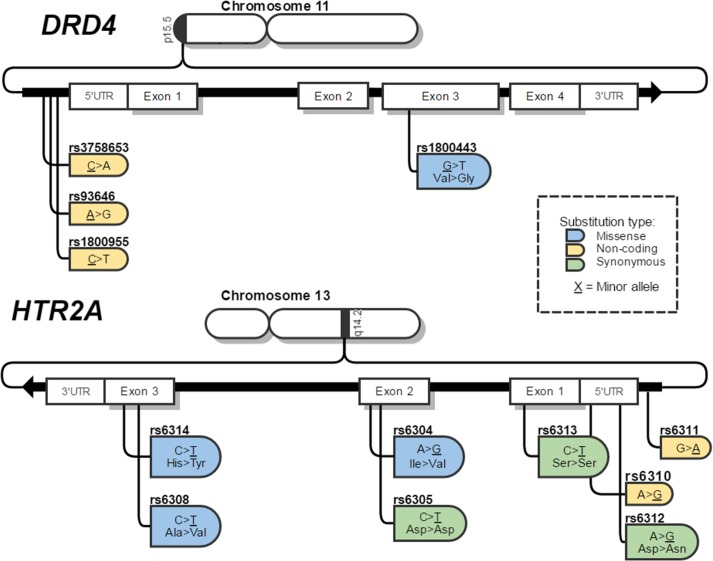
Diagram of HTR2A and DRD4 and SNPs selected for this study.